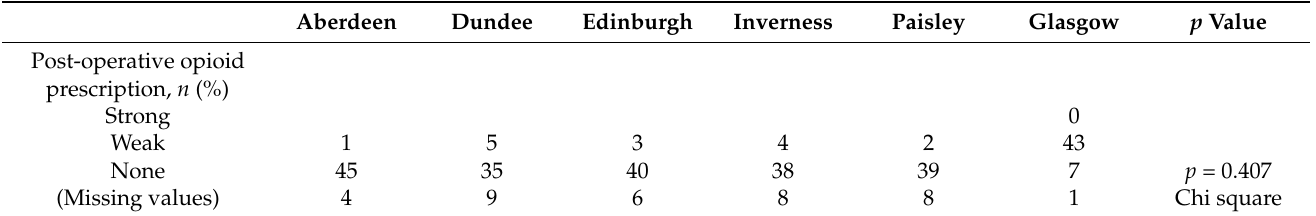
Table 3. Rates of post-operative opioid prescription in the distal radius fracture cohort.